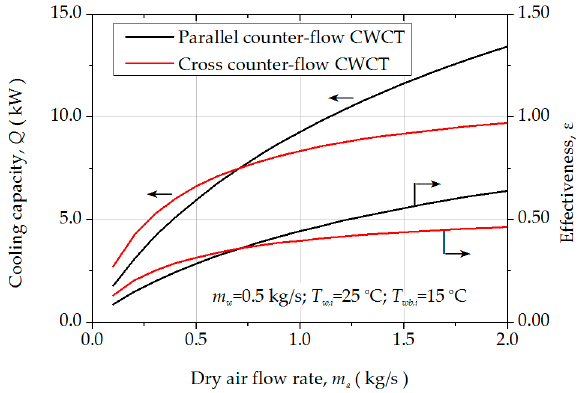
Figure 5. Variations of the cooling capacity and the effectiveness with air flow rate (the arrows indicate the variable axes).